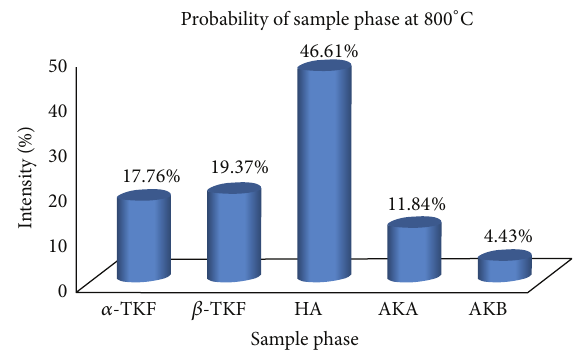
Figure 5: Percentage probability sample phase sintering at a temperature 800 ∘ C, where HA = Ca 10 (PO 4 ) 6 (OH) 2 , 𝛼 -TKF = 𝛼 - Ca 3 (PO 4 ) 2 , 𝛽 -TKF = 𝛽 Ca 3 (PO 4 ) 2 , AKA = Ca 10 (PO 4 ) 6 CO 3 and AKB = Ca 10 (PO 4 ) 6 CO 3 (OH) 2 .